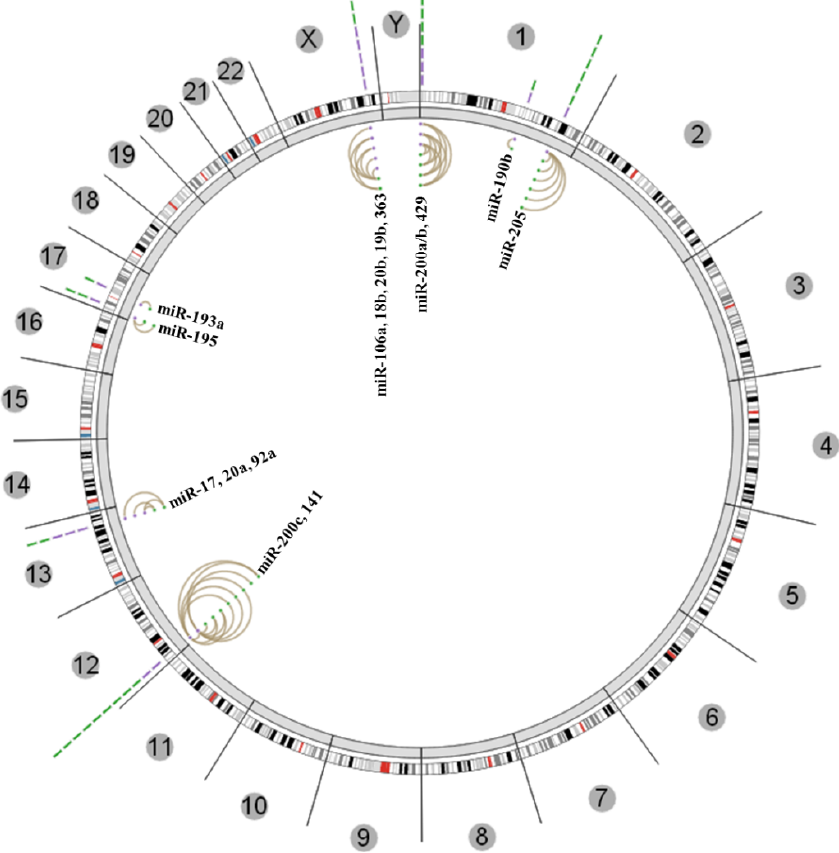
Figure 2. Significant negative correlation between altered miRNA expression and DNA methylation pattern in primary prostate cancer tumors from the TCGA data-set. Circos plot showing miRNAs where there is a significant correlation with CpGs near miRNA gene locations. Outer ring represents all the chromosomes. MiRNA genes are represented by purple lines near their chromosomal locations. Green lines represent CpGs in the region. Lines connecting two dots represent the statistically significant correlation between two features selected, miRNA expression and CpG methylation in this case. (Figures generated from [125] using latest version of data release for Prostate cancer